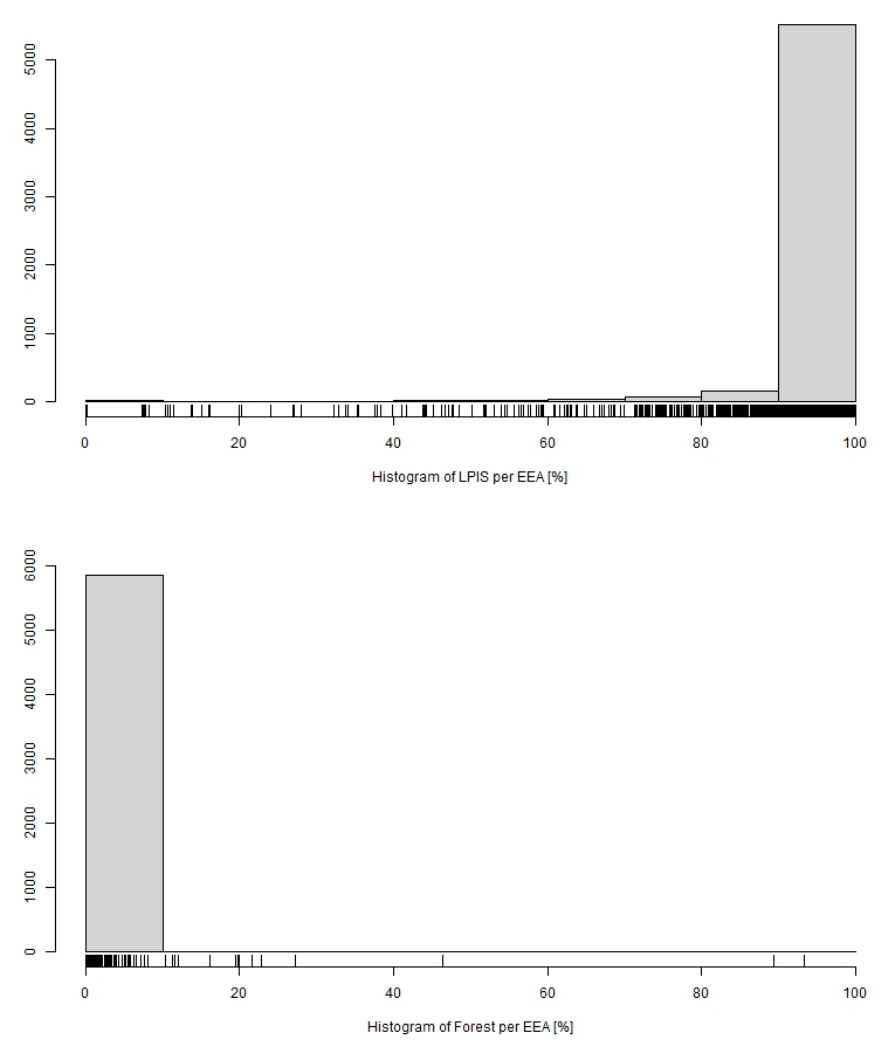
Figure 8. Distribution of EEAs by percentage of arable (LPIS) and forested land (Forest). Characteristics of horizontal axis (LPIS) are as follows: Min.: 0.00%; Q1: 98.30%; Median: 99.60%; Mean:97.00%; Q3: 99.90%; Max.:100.00%; SD: 9.99%. Characteristics of horizontal axis (Forest) are as follows: Min.:0.00%; Q1:0.00%; Median:0.00%; Mean: 0.15%; Q3: 0.00%; Max.: 93.30%; SD: 2.00%.